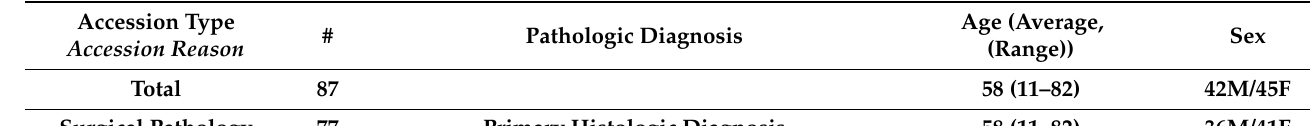
Table 1. Patient demographics, clinical history, histologic diagnosis. M, male; F,